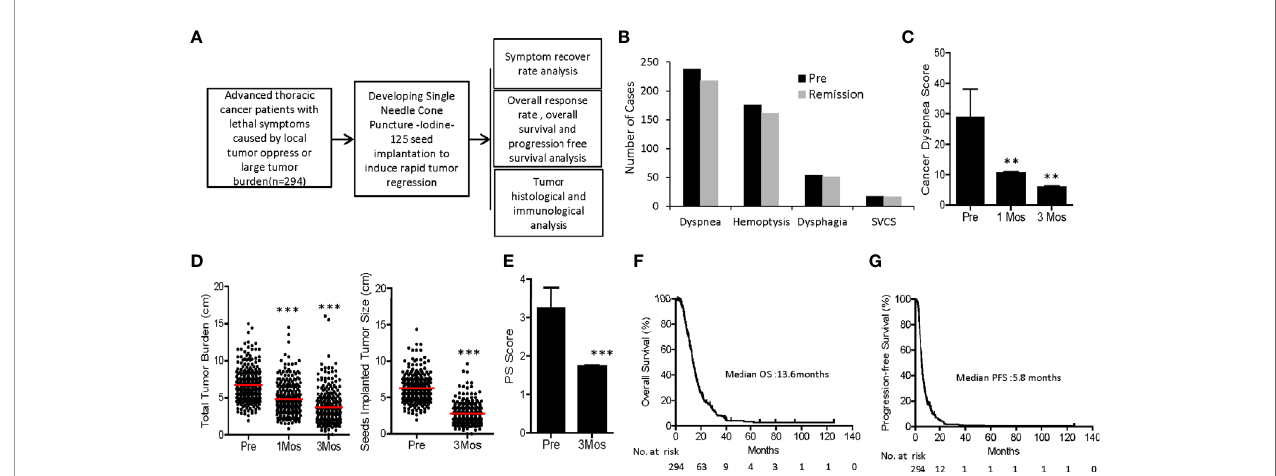
FIGURE 1 | Flow chart and clinical outcomes of SNCP- 125 I brachytherapy-treated patients with incurable thoracic malignancy. (A) An overall work fl ow of the present study. (B) Hemoptysis and life-threatening symptoms including dysponea, dysphagia and superior vena cava syndrome due to local tumor oppressions were greatly alleviated in 2 weeks to 1 month. (C) Cancer dysponea score was signi fi cantly decreased 1- and 3-month after treatment. Cancer dysponea score was calculated according to the widely used Cancer Dyspnoea Scale reported by Tanaka et al. (27). (D) Overall tumor burden and change of tumor size after treatment in 294 patients 1 month and 3 months post SNCP- 125 I brachytherapy. 26 patients showed partial response (PR), 1 patient with complement response (CR) and 3 patients with stable disease (SD). (E) Performance status of all 294 patients was greatly improved following SNCP- 125 I brachytherapy. (F, G) . Overall survival (OS) and progression-free survival (PFS) curves of 294 patients. The median OS and PFS were 13.6 months and 5.8 months, respectively. Survival curves were analyzed using the Log-rank (Mantel-Cox) Test. SVCS, superior vena cava syndrome. *p < 0.05; **p < 0.01; ***p < 0.001.